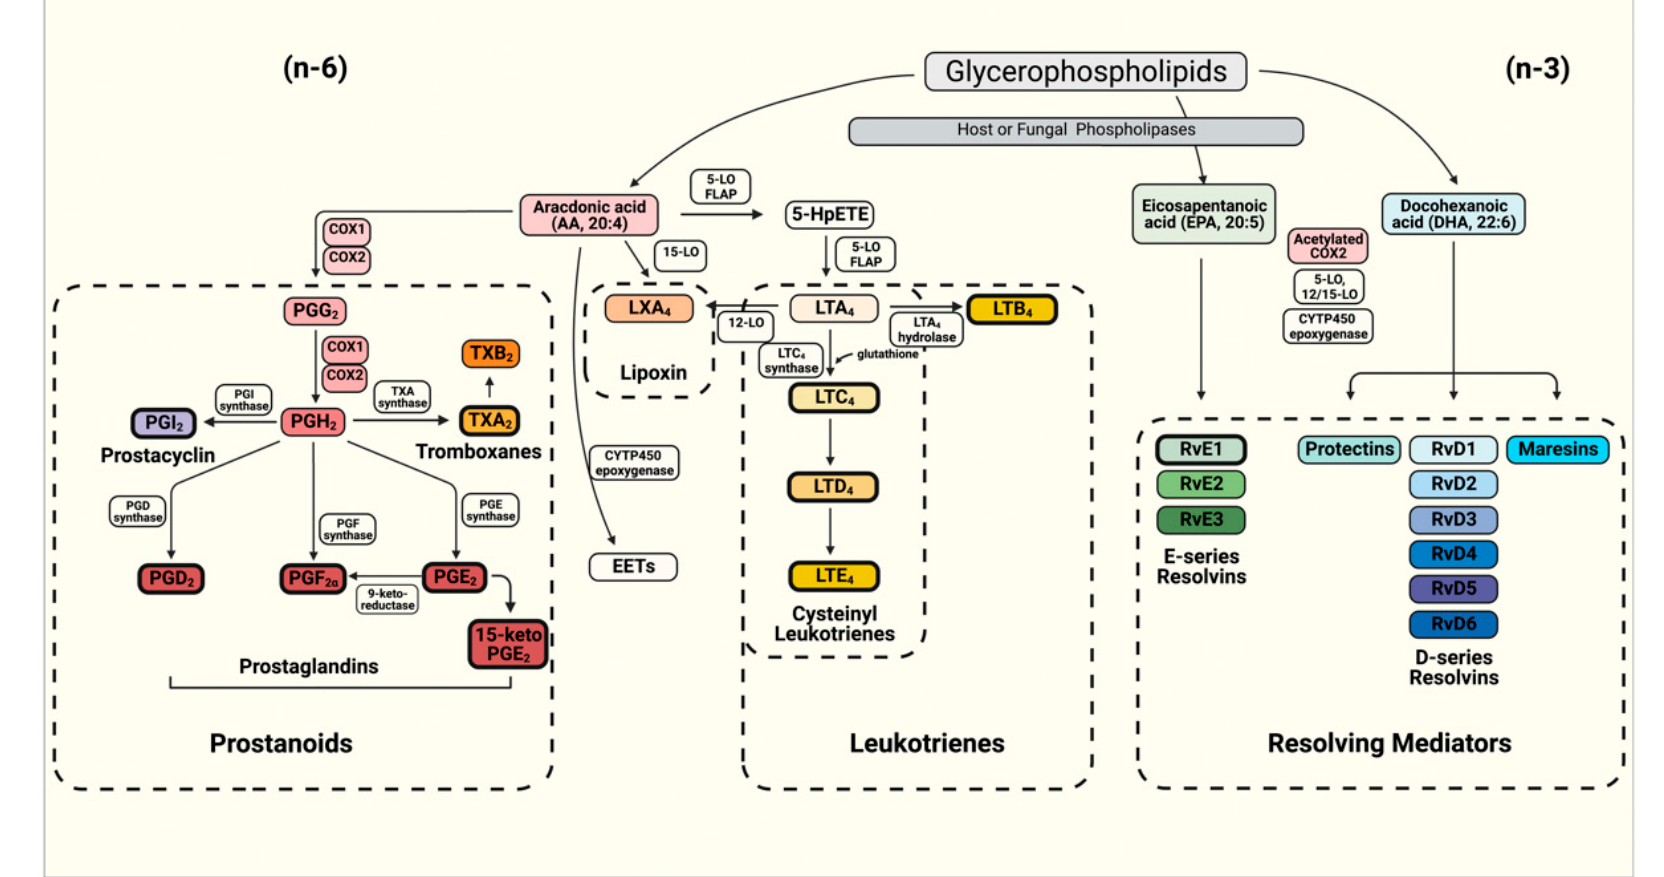
Figure 1. Schematics of the eicosanoids synthesis pathway for the production of prostanoids (Prostaglandins—PGs, Prostacyclin and Thromboxanes—TXs), Leukotrienes (LTs) and resolving mediators including D- and E-series resolvins (Rvs), protectins and maresins. The boxes depicted with bold borders illustrate the eicosanoids produced by